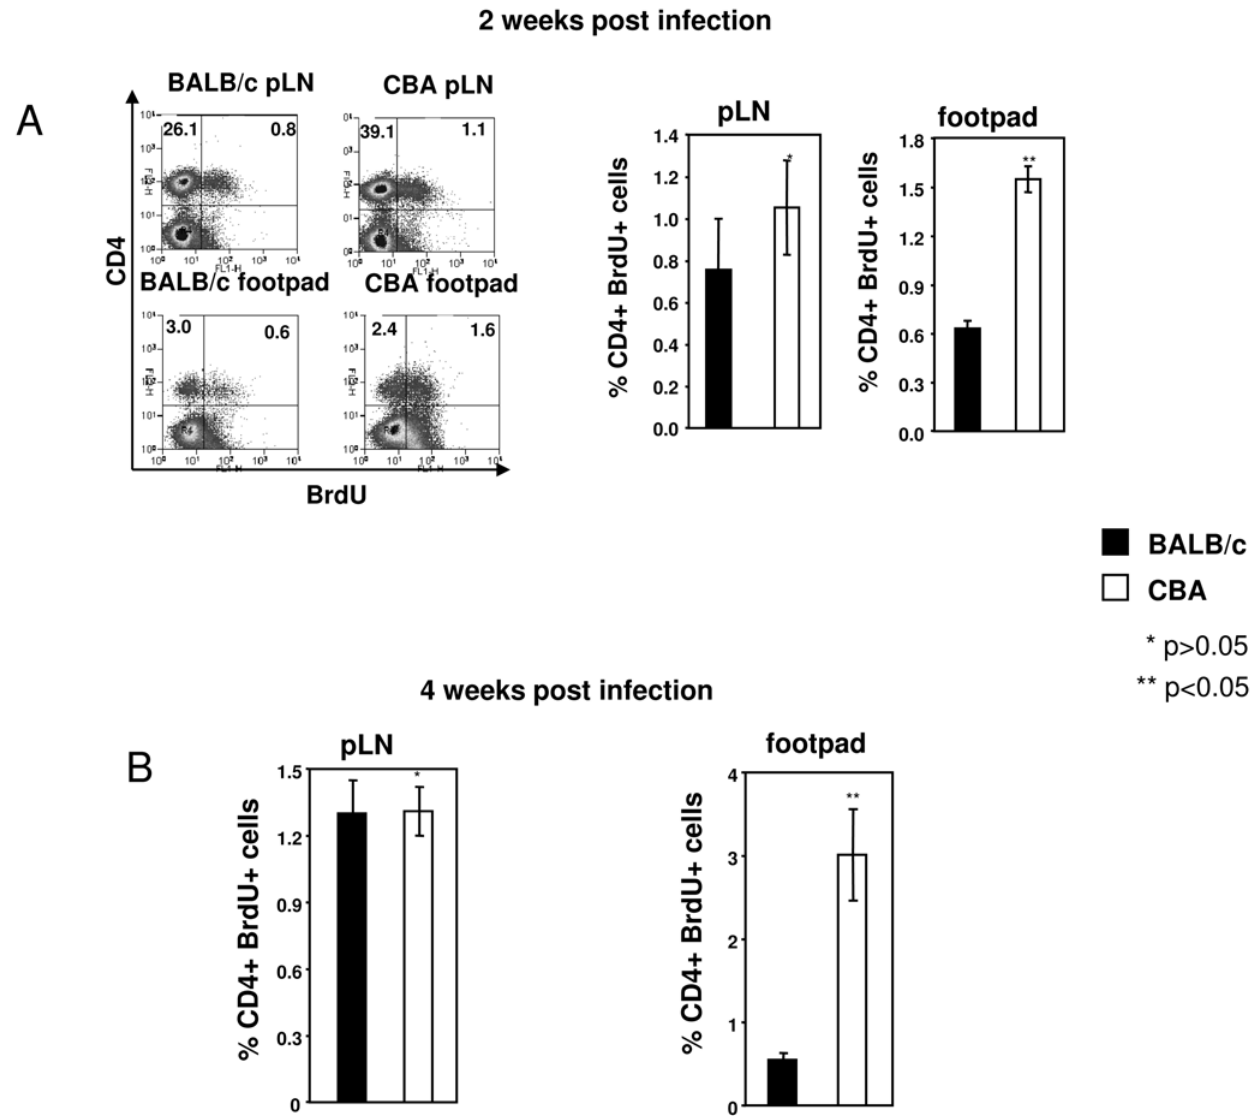
Figure 2. Impaired proliferation of antigen-specific CD4 + T cells. Groups of BALB/c and CBA mice (n=8) were infected with L. major parasites for two (A) or four (B) weeks and were injected with 1 mg BrdU daily for 4 days. Individual popliteal lymph nodes and footpads (pool from at least two footpads) were harvested and the % of proliferating CD4 + T cells was determined by flow cytometry. (2A) left panels: dot plot profiles of CD4 + BrdU + T cells 2 weeks post infection; right panels: % of CD4 + BrdU + T cells 2 weeks post infection. (2B) % of CD4 + BrdU + T cells 4 weeks post infection. Error bars represent standard deviations. Isotype control: 0.27%. Data show the results of one representative experiment out of three independent